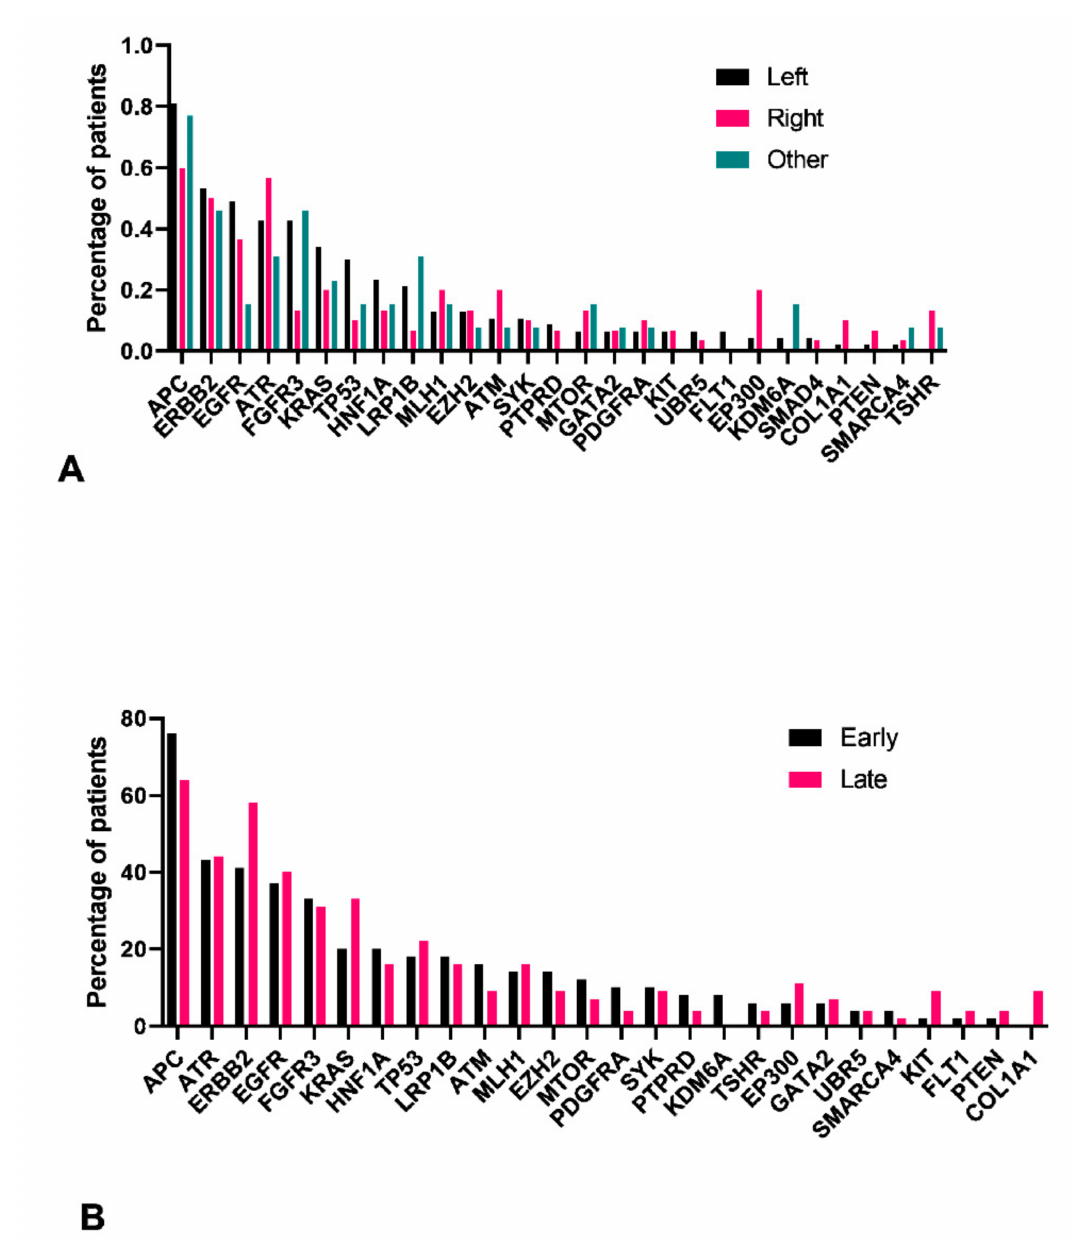
Figure 4. Frequency of variants in 27 genes among samples with at least one confirmed pathogenic variant for the large intestine. Frequency of variants based on tumor location ( A ) and stage ( B ). Y -axis denotes the number of samples with at least one confirmed pathogenic variant for the large intestine for that particular gene. For location, each bar is divided into left, right, and other categories, whereas for stage, they were grouped into early (stage I and II) and late (stage III and